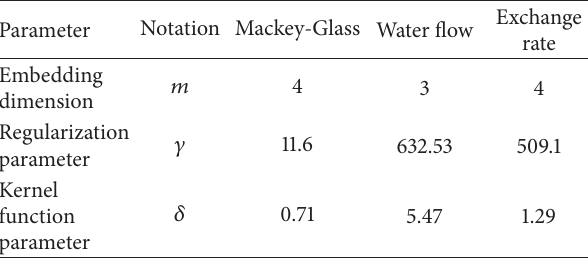
Table 2: Optimal tuning parameters of the FLSVR